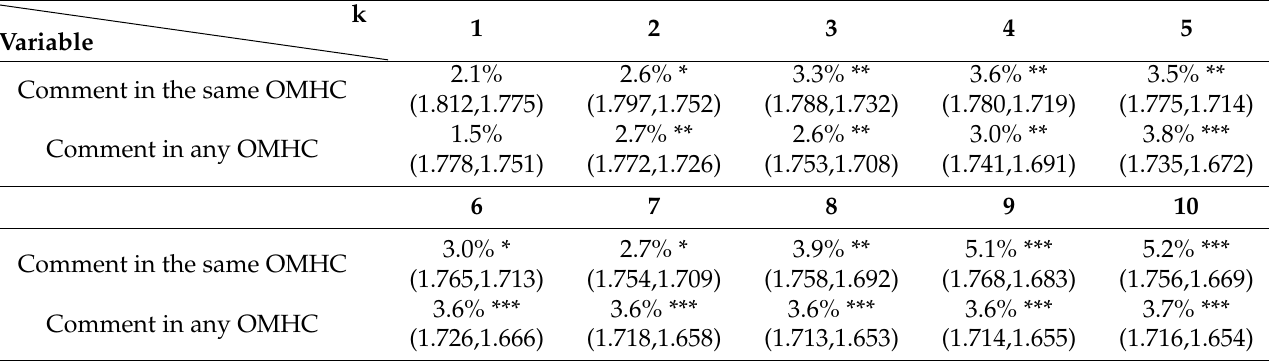
Table 4. The difference in the empathy score of users’ subsequent k comments between “empathic comment group” (left) and “non-empathic comment group” (right), and their respective values. * p < 0.05, ** p < 0.01, *** p <